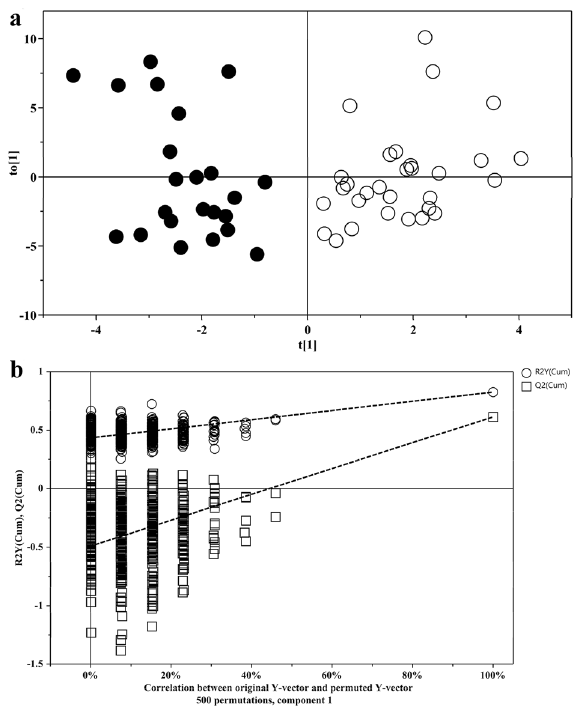
Figure 1. (a) OPLS-DA scores plot: controls (full circle), IEI-EMF subjects (open circle). ( b) Validation plots of OPLS-DA model using a permutation test (n = 500). The horizontal axis shows the correlation between the permuted and actual data, while the vertical axis displays the cumulative values of R2 and Q2. The intercept gives an estimate of the overfitting